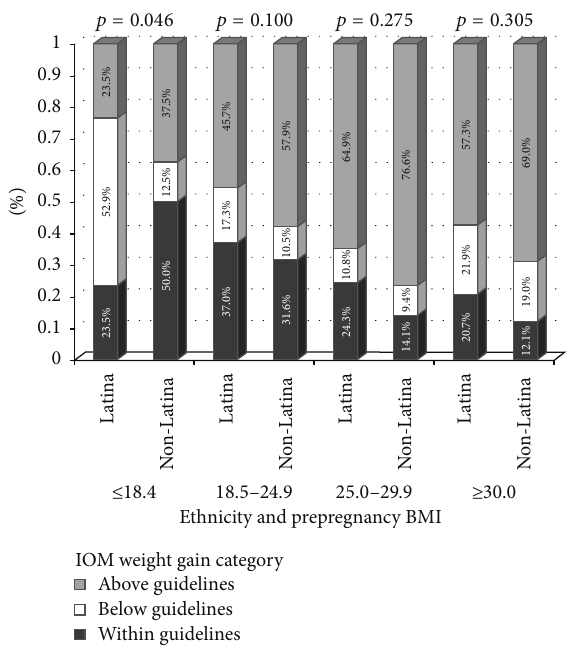
Figure 2: Gestational weight gain status by prepregnancy BMI for White non-Latina and Latina